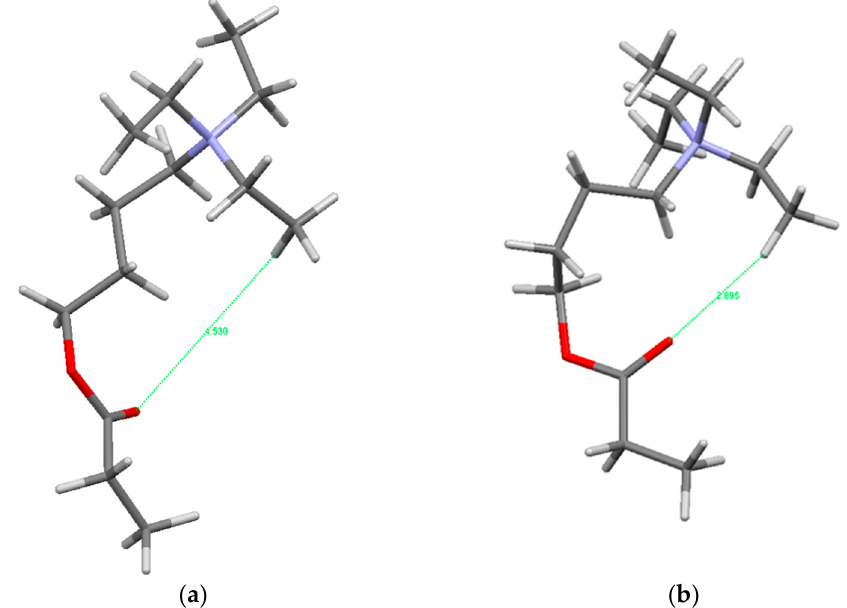
Figure 7. ( a ) DFT optimized structure of the C4 surfactant obtained using a conformer of the pcg as initial geometry; ( b ) DFT optimized structure of C4 obtained using a conformer of sc as initial geometry.